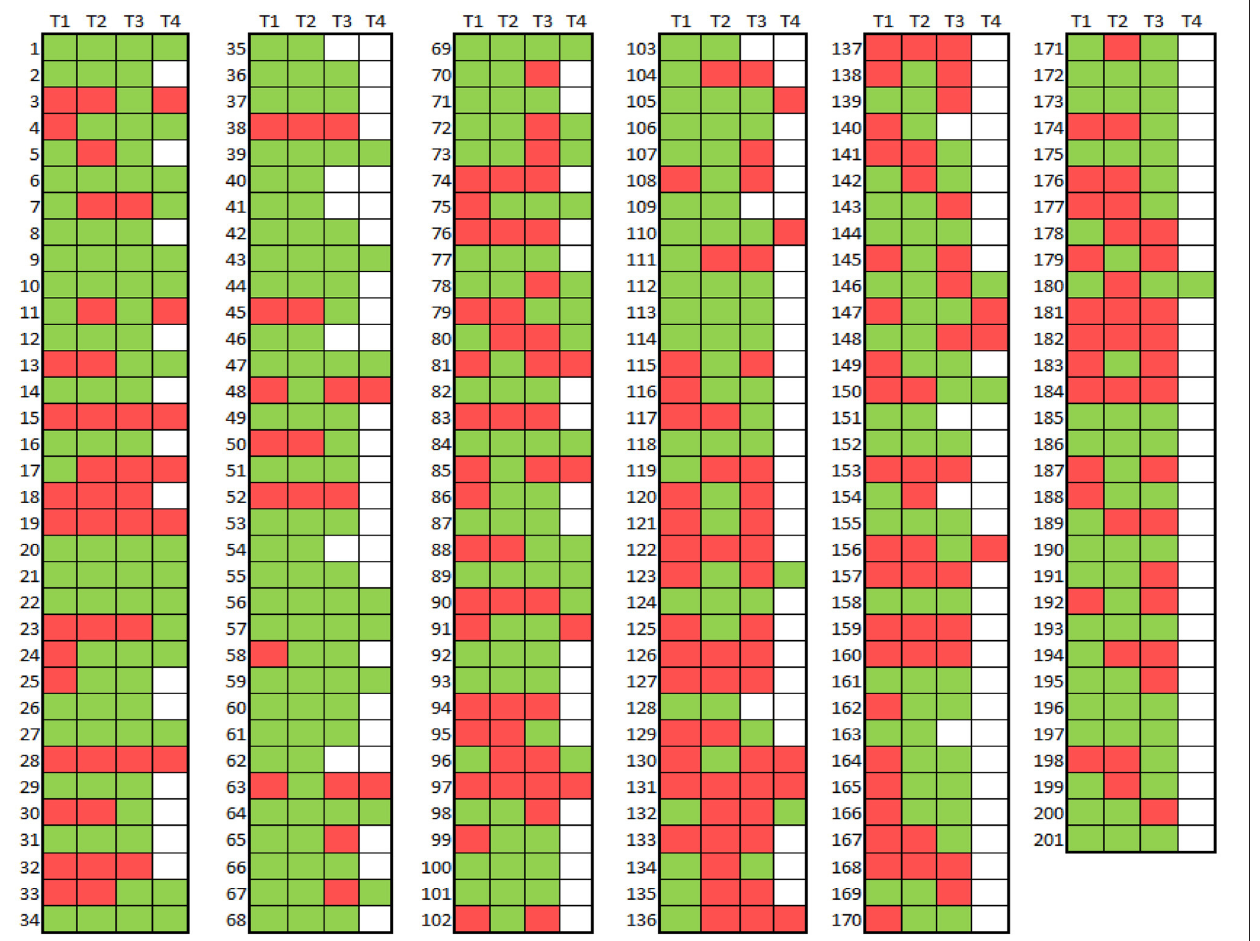
FIGURE 3 | Map of ET vs. ET plus diagnoses across four time intervals in 201 participants Diagnosis = ET (red), Diagnosis = ET Plus (green). No diagnosis (i.e. no evaluation) =